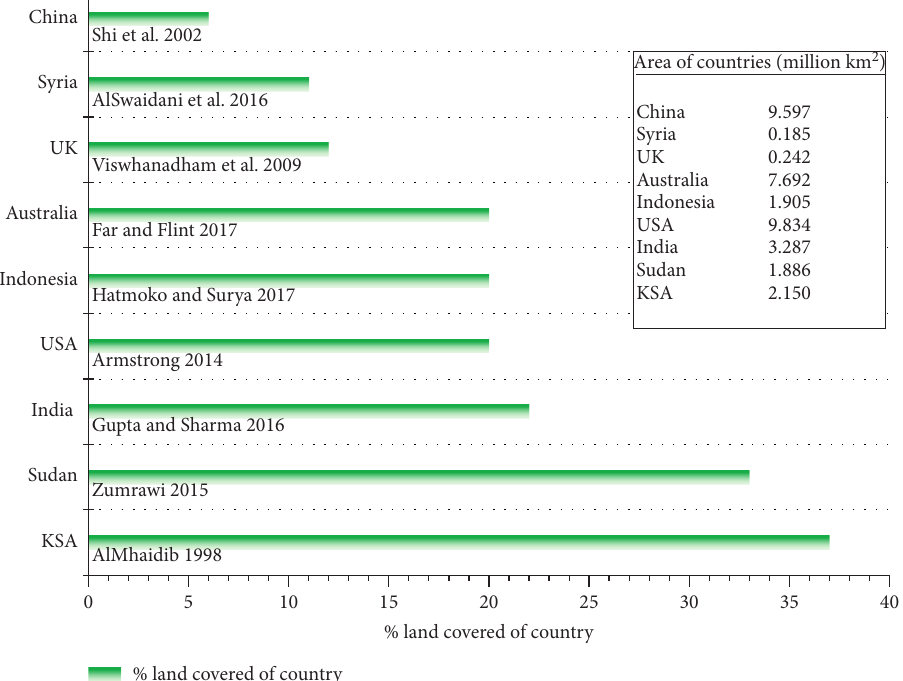
Figure 2: Percentage of covered area of expansive soils for countries where expansive soil is in